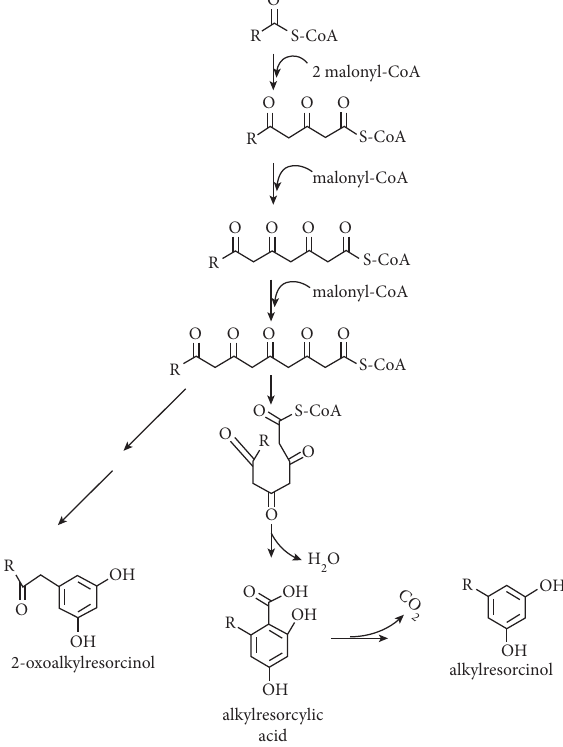
Figure 2: A proposed biosynthetic pathway of ARs by PKSIII according to